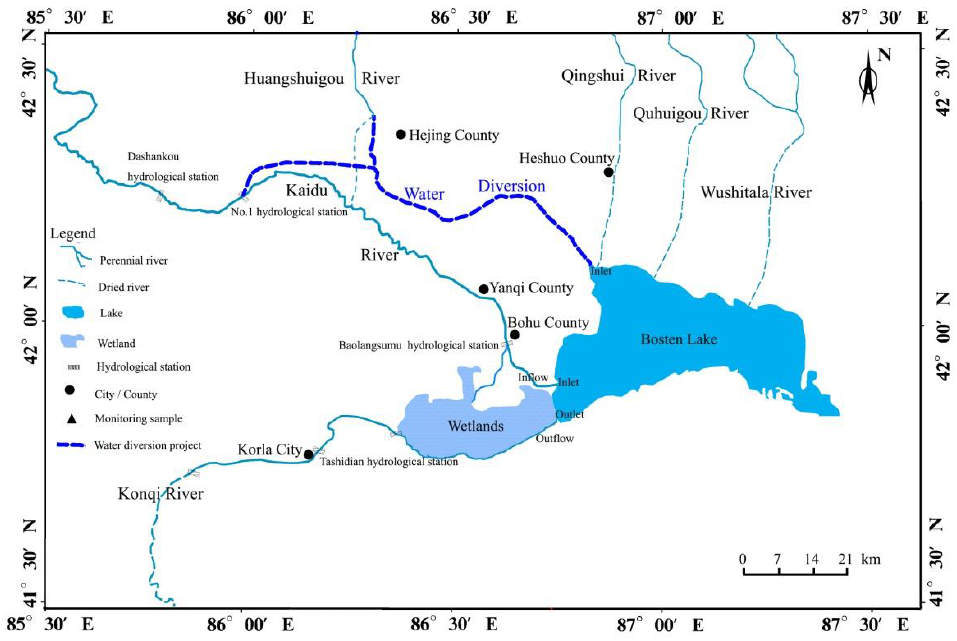
Figure 8. The route of the river–lake system connectivity project (water diversion) in Bosten Lake.